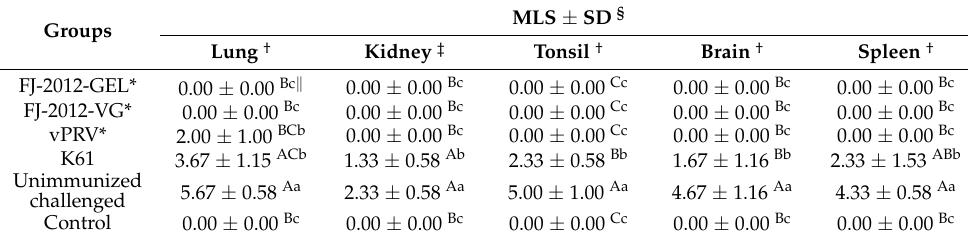
Table 4. Microscopic lesion scores of tissue in piglets after challenge with the PRV FJ-2012. MLS ± SD § Groups Lung † Kidney ‡ Brain †